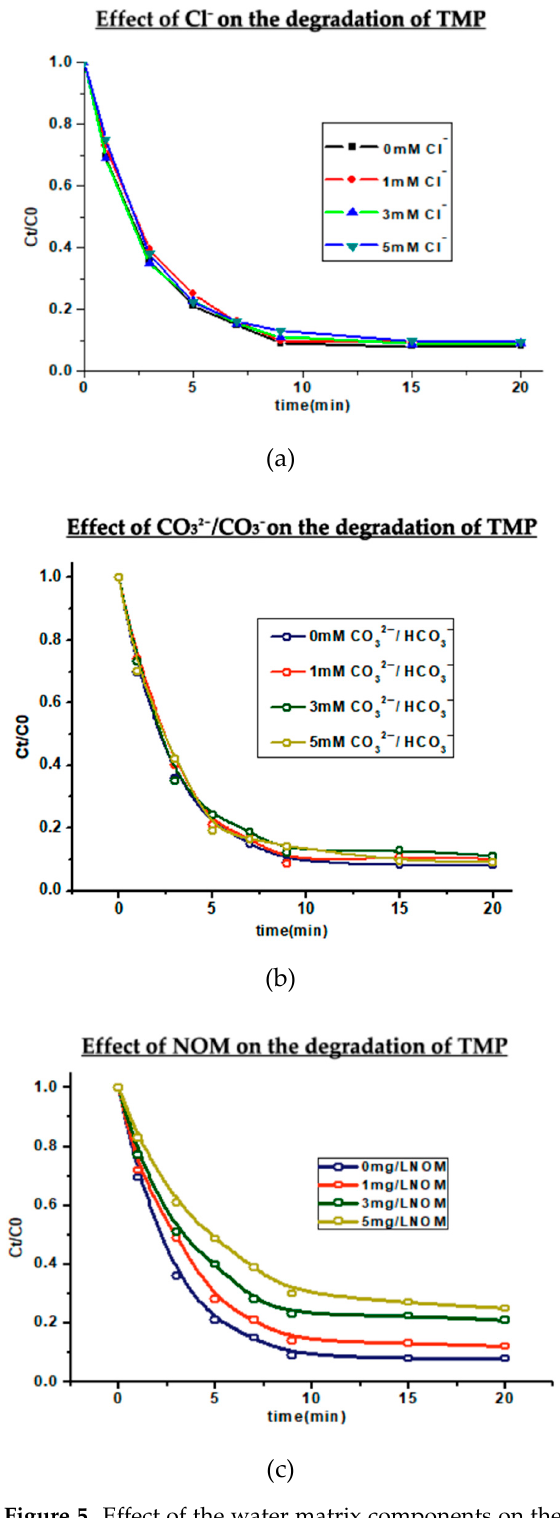
Figure 5. Effect of the water matrix components on the degradation of TMP in the UV/free chlo- rine process. ( a ) Effect of chloride ion (Cl − ), [TMP] 0 = 0.01 mM, [free chlorine] 0 = 0.05 mM, [Cl − ] 0 = 1 mM to 5 mM; ( b ) Effect of HCO 3 − / CO 3 2 − [TMP] 0 = 0.01 mM [free chlorine] 0 = 0.05 mM, [HCO 3 − / CO 3 2 − ] 0 = 1 mM to 5 mM; ( c ) effect of NOM, [TMP] 0 = 0.01 mM [free chlorine] 0 = 0.05 mM, [NOM] 0 = 1 mg/L to 5 mg/L. UV light intensity = 9.45 × 10 − 7 Einstein/L